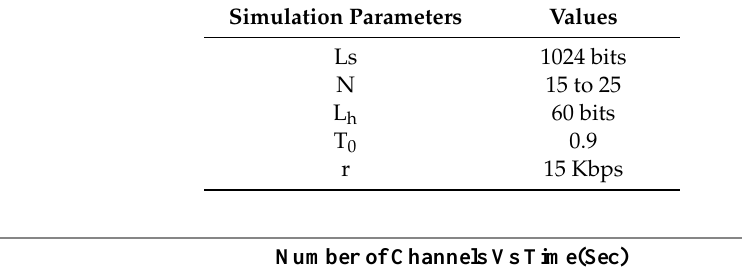
Table 3. Simulated Parameters.